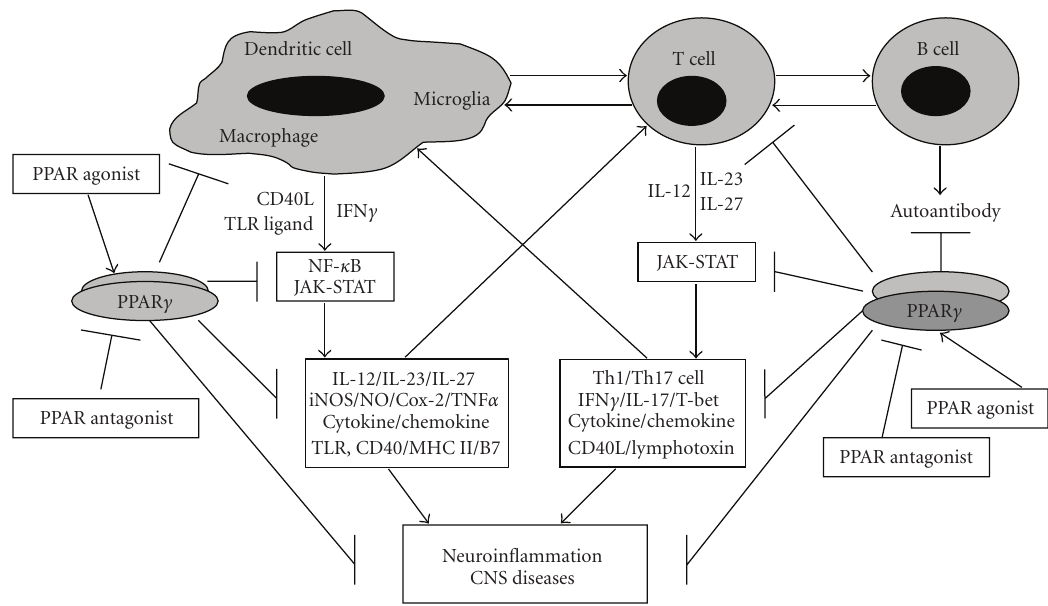
Figure 2: Regulation of neuroinflammation by PPAR agonists in CNS diseases. CD40/TLR induce the activation of NF- κ B pathway leading to expression of IL-12 family cytokines from APCs which in turn signal through Jak-Stat pathway in T cells leading to Th1/Th17 di ff erentiation and development of CNS diseases. PPAR agonists modulate signaling and transcription in APC and T cells thereby preventing CNS diseases.